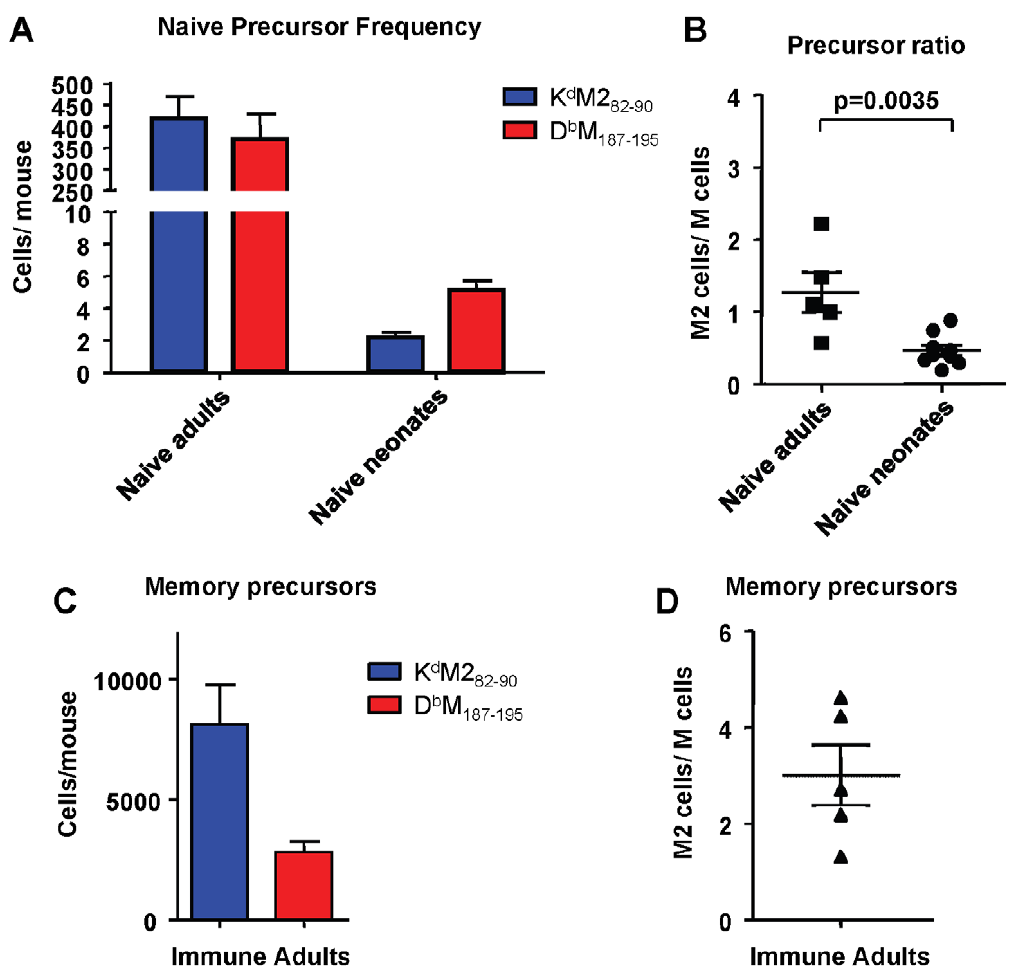
Figure 8. Epitope-specific CD8 + T cell precursor frequency analysis in adult and neonatal mice. (A) Precursor frequencies of epitope- specific CD8 + T cells in naı¨ve adult and neonatal mice as determined by the double tetramer enrichment method. (B) K d M2 82-90 /D b M 187-195 precursor frequency ratios in naı¨ve adults and neonates. (C) Epitope-specific memory CD8 + T cell precursor frequencies in adult mice infected one month previously with RSV. (D) Memory CD8 + T cell precursor ratios. Data are representative of several independent experiments with 5-12 mice/group. Error bars represent the SEM.